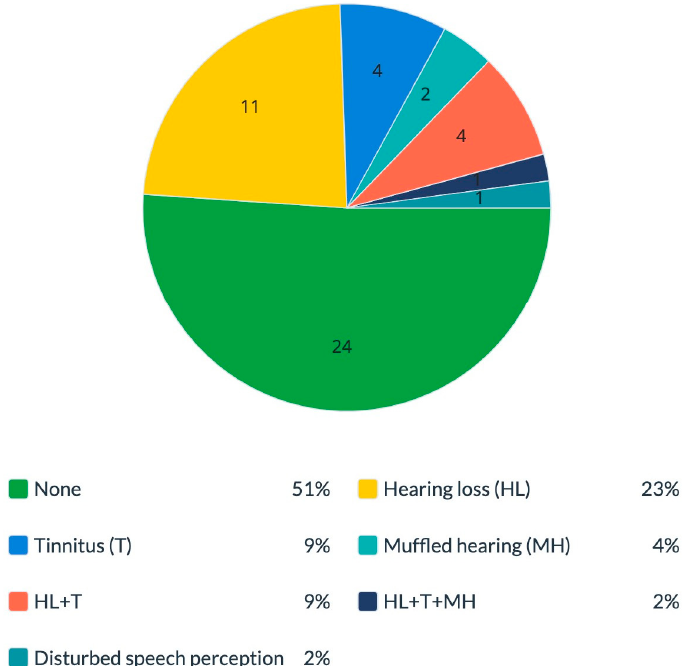
Figure 3. Hearing manifestations after silicone breast implant removal among women who under- went implant removal. The percentage of different hearing manifestations among symptomatic women who complained of hearing impairments after they underwent silicone implant removal surgery. Total 100% is equal to n=47 subjects. HL—hearing loss; T—tinnitus; MH—muffled hear- ing.